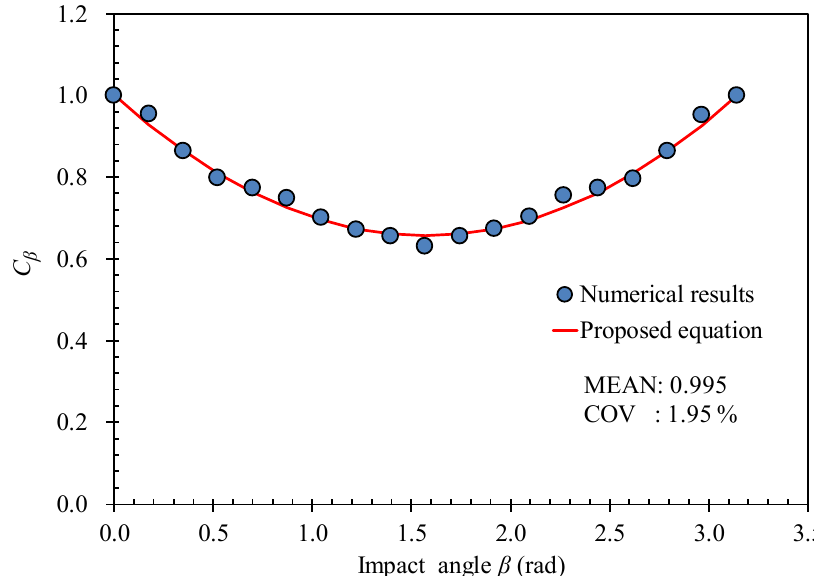
Figure 10. E ff ects of impact angle on the extent damage of the ring-sti ff ened Figure 10. Effects of impact angle on the extent damage of the ring-stiffened cylinder.